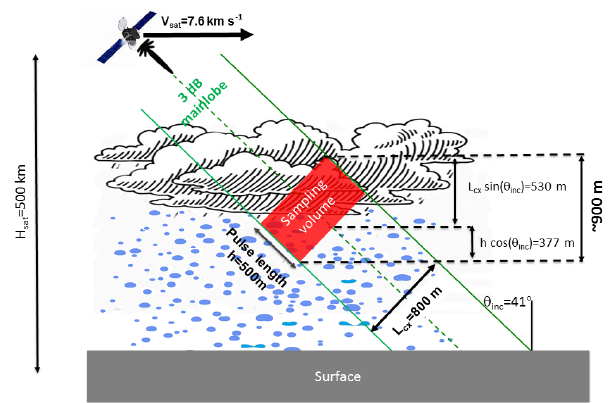
Figure 2. Schematic illustrating the geometry of a radar observing cloud and precipitation at a slant angle. The specifics of the radar are detailed in Table